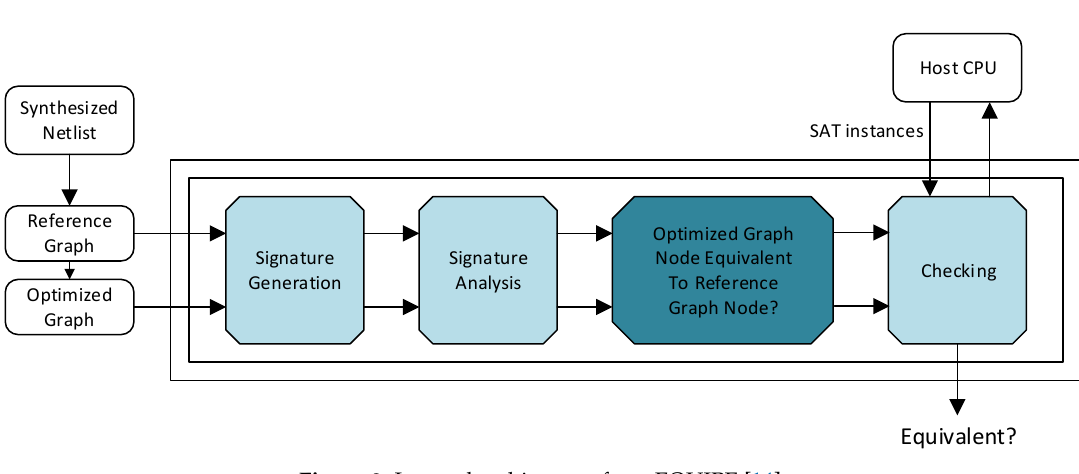
Figure 9. Internal architecture from EQUIPE